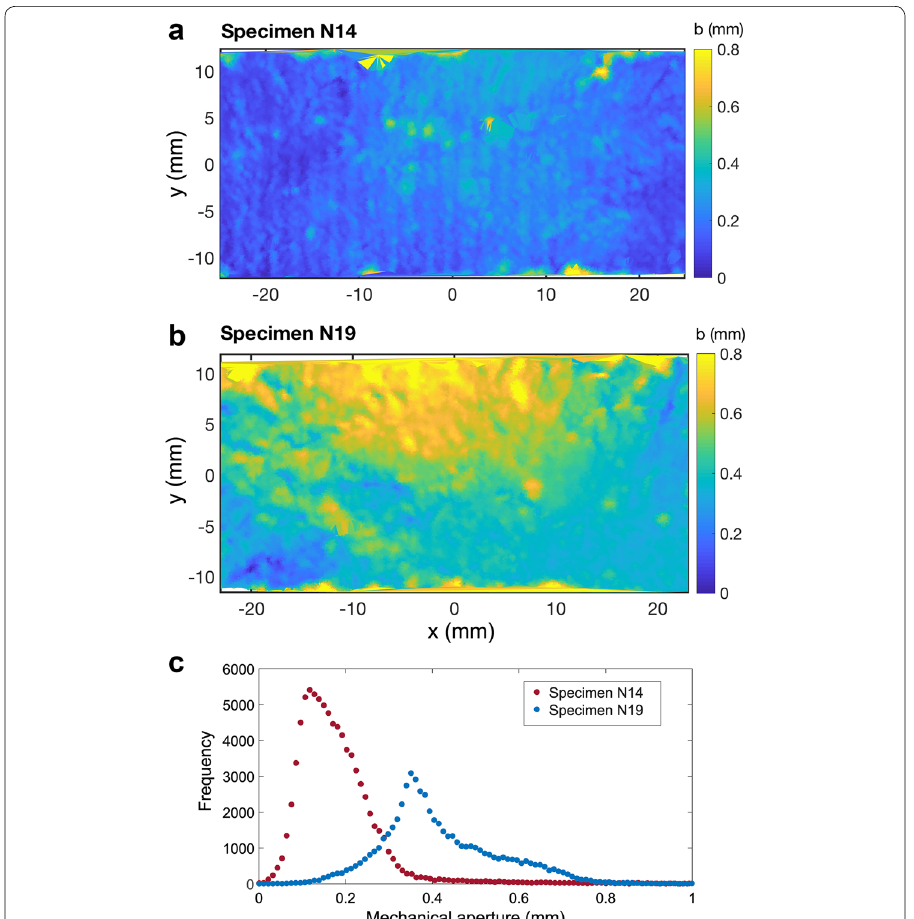
Fig. 3 Aperture distributions. Aperture fields of Specimens a N14 and b N19. c Probability distribution functions of the apertures of Specimens N14 and